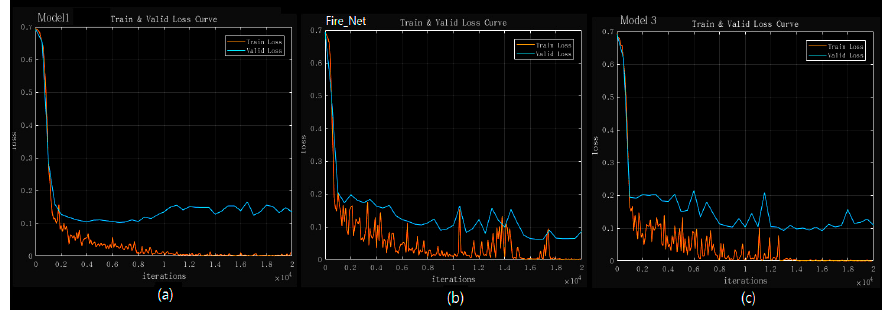
Figure 8. Training and validation loss curve of the three models: ( a ) Model 1; ( b ) Fire_Net; ( c ) Model 3. The curve is computed over an epoch of 20,000 iterations. The training loss is marked every 100 iterations while the validation loss is recorded every 500 iterations. Table 6. Effects of model architecture on performance and runtime.